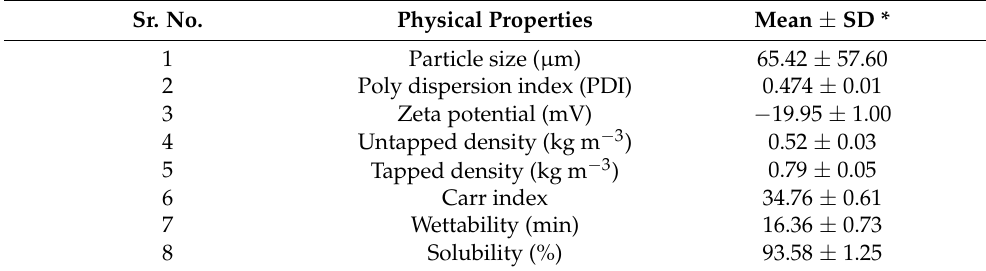
Table 1. Physical properties of freeze-dried crude tuna pepsin powder containing 10% maltodextrin and 5% trehalose.